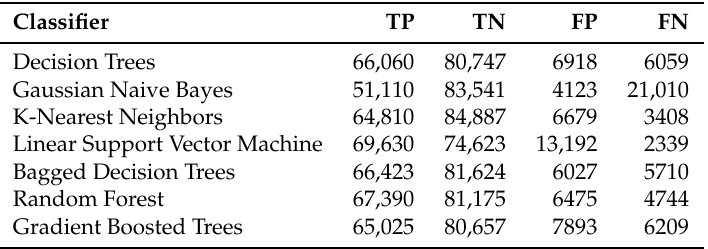
Table 4. Components of the confusion matrices for real data.